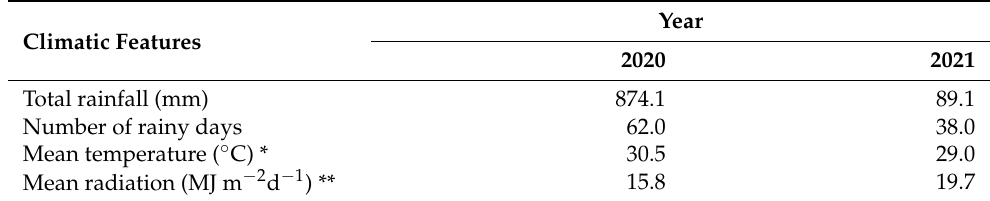
Table 2. Soil properties at the research